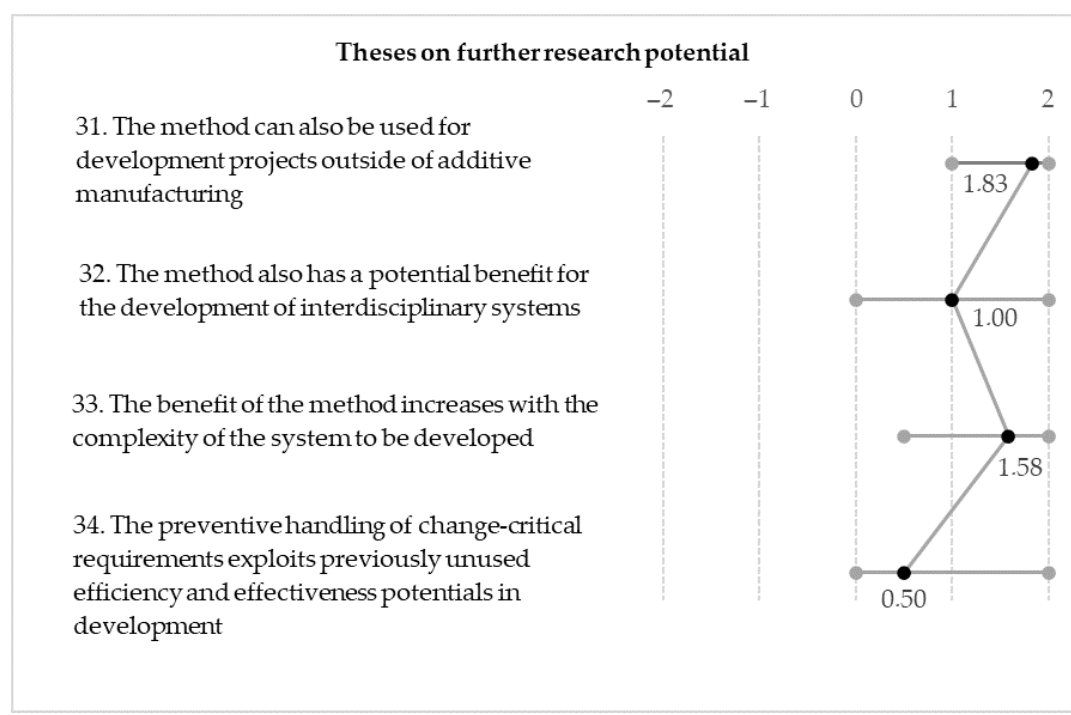
Figure A6. Questionnaire results on area “future research potentials”.